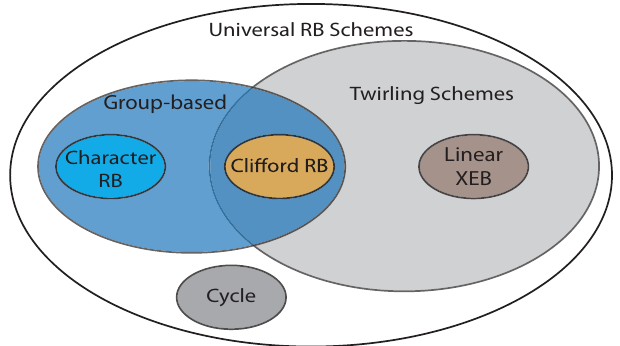
FIG. 2. A diagram showing the relationships between different classes of RB schemes, including our URB framework and class of twirling schemes. Character RB refers to the class of schemes in Ref. [29]. The space made by the URB and twirling classes leaves room for potentially new